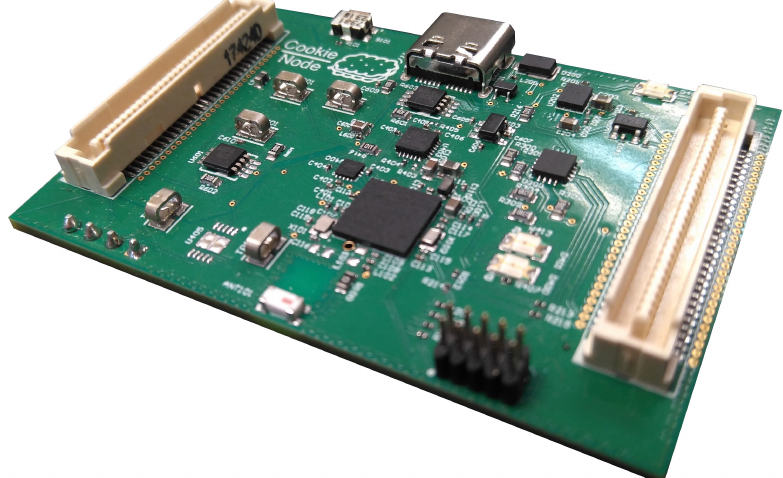
Figure 2. Implementation of the Cookie node with Silicon Labs EFR32 MCU and Microchip ATECC608A Cryptographic